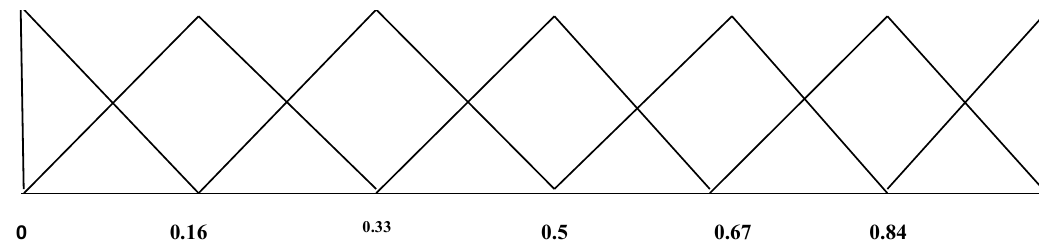
Fig. 3. Linguistic rating on membership function corresponding to fuzzy